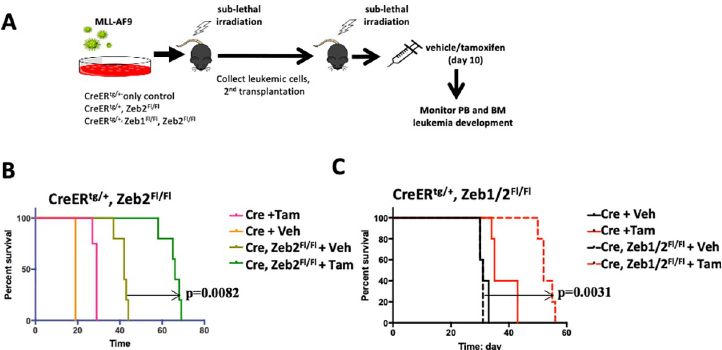
Fig 9. Inducible deletion of Zeb1/2 increases in vivo survival in MLL-AF9 secondary transplant settings. (A) Schematic of inducible deletion strategy to investigate the effects of Zeb2 and Zeb1/2 deletion on secondary leukemia progression. (B) Tam-induced Zeb2 deletion was found to significantly increase overall survival of mice transplanted with MLL-AF9 secondary tumor cells compared to nontreated Veh treated controls (median survival 66 versus 42 days, p = 0.0082, Mantel–Cox test). There was a significant effect of Tam in Cre only treated samples compared to Veh controls (median survival 29 versus 19 days, p = 0.0082, Mantel–Cox test). (C) Tam-induced deletion of both Zeb1 and Zeb2 was also found to significantly increase overall survival of mice transplanted with MLL-AF9 secondary tumor cells compared to nontreated Veh treated controls (median survival 58 versus 31 days, p = 0.0031, Mantel–Cox test). There was a significant effect of Tam in Cre only treated samples compared to Veh controls (median survival 42 versus 31 days, p = 0042, Mantel–Cox test). N = 5 mice/treatment group for all arms of the experiments. Raw data behind graphs are included in F of S1 Data. BM, bone marrow; PB, peripheral blood; Tam, tamoxifen; Veh,